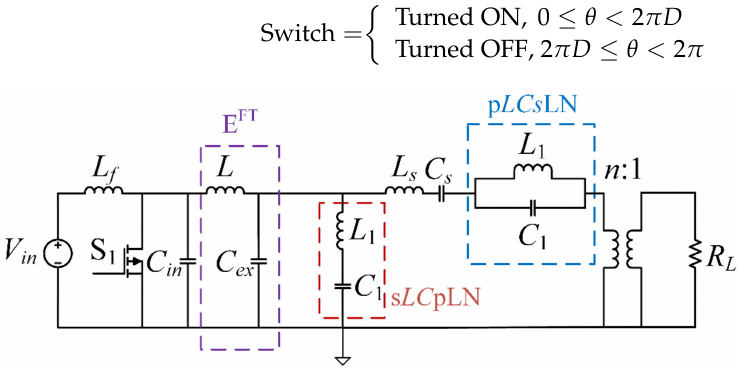
Figure 1. The class E and enhanced class E topologies with auxiliary resonant networks.